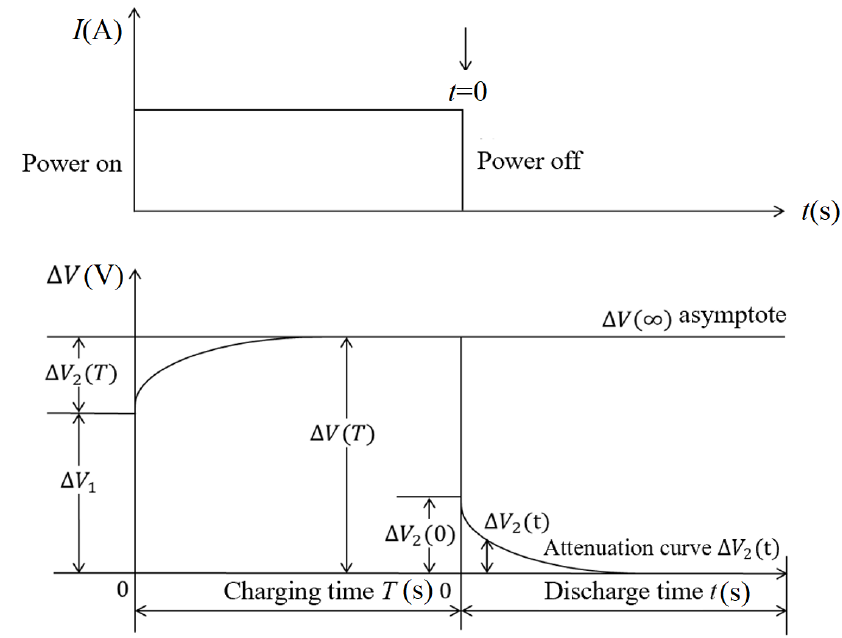
Figure 2. Voltage difference of time-domain IP measurements [10].